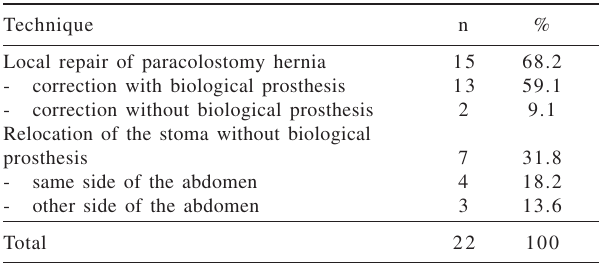
Table 1 - Distribution of patients according to